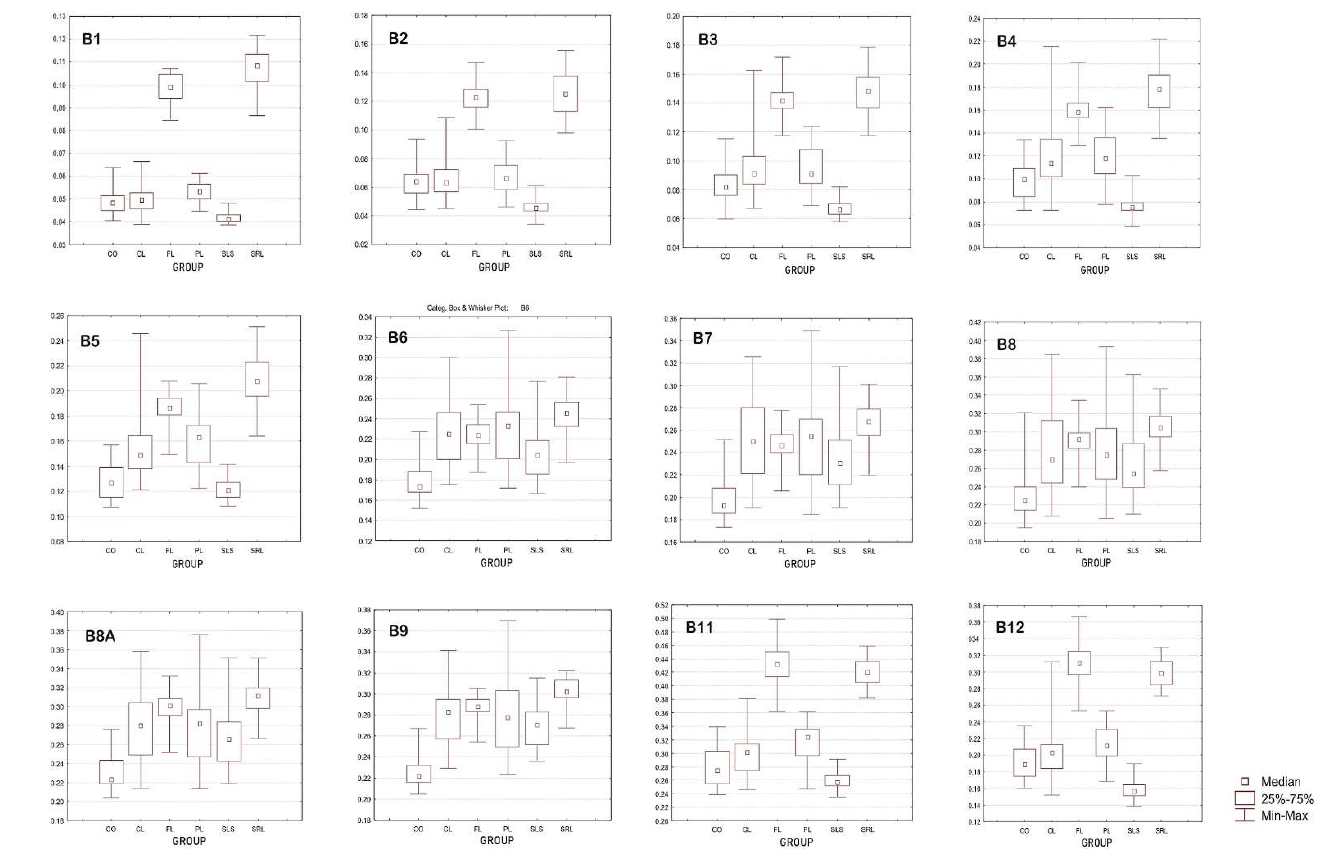
Figure 12. Grouped boxplots for each band ( B1 – B12 ) and lithological group (SRL, FL, CO, PL, CL, SLS).